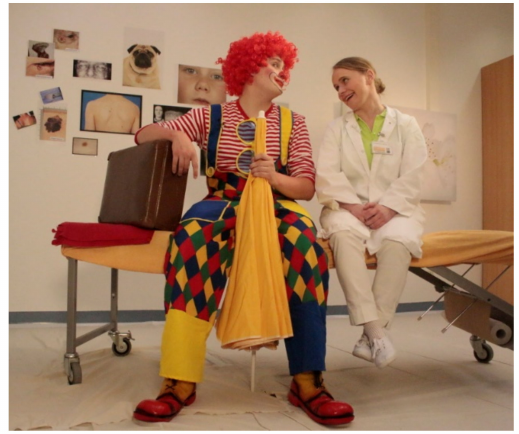
Figure 6. Clown Zitzewitz and dermatologist in the film of the media-based workshop © NCT/UCC 2018.